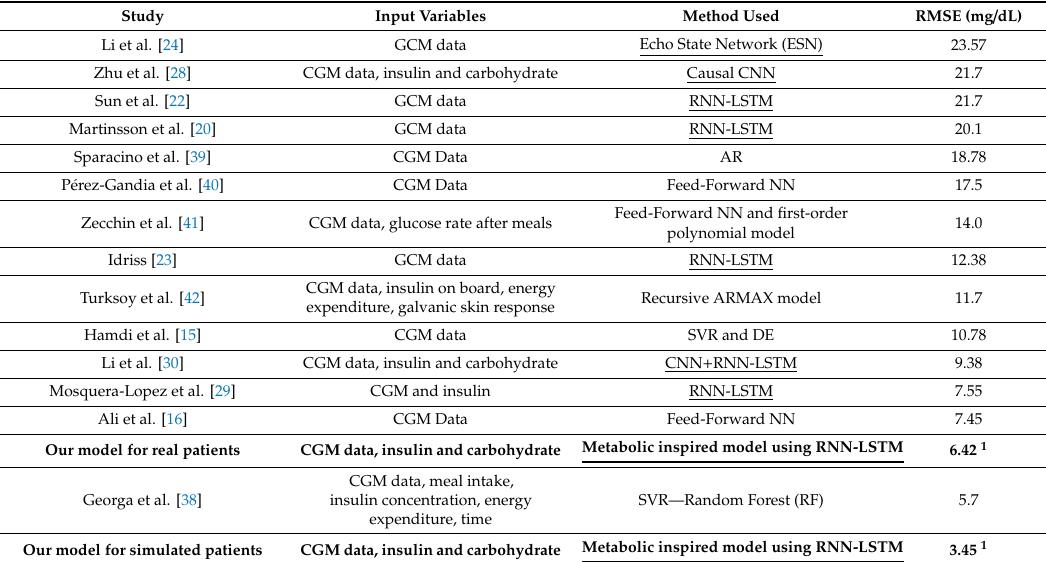
Table 4. RMSE for 30 min Blood Glucose (BG) estimation using deep (underlined) and shallow learning